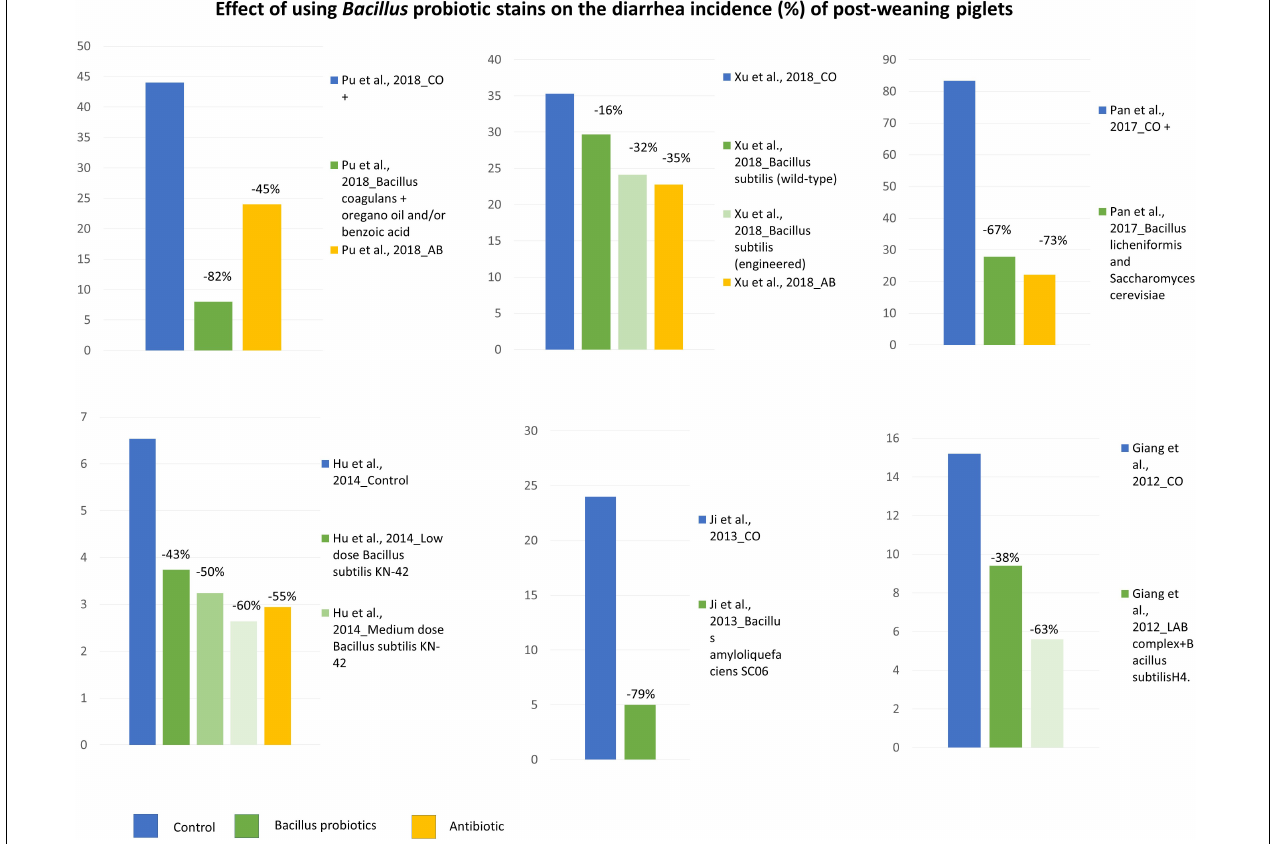
FIGURE 2 | The effect of Bacillus probiotics on the diarrhea incidence (%) of post-weaning piglets as compared with no probiotic or antibiotic supplementation.